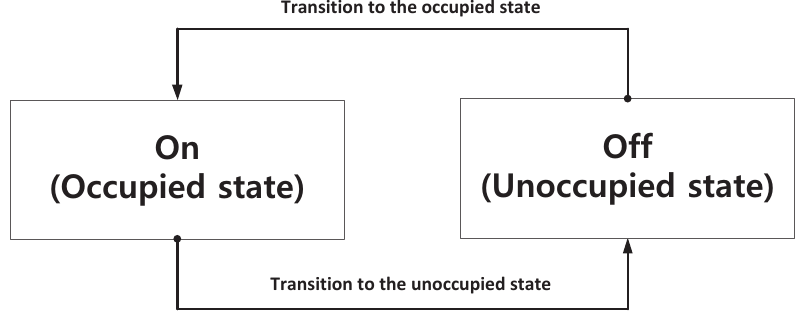
Figure 4. Conceptual diagram of changes in PU channel occupancy